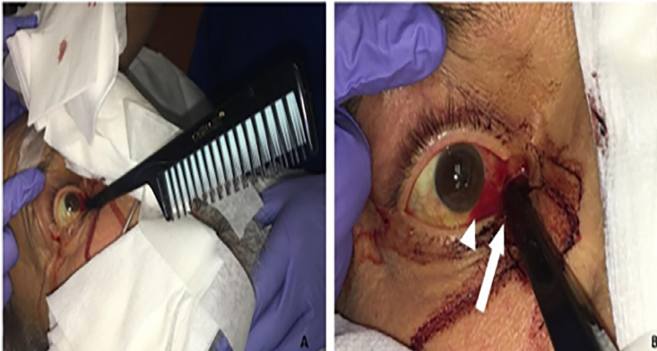
Image 1. Hair comb impaled into the right inferomedial orbit (A) with higher magnification (B) of the foreign body with right conjunctival laceration at the nasal limbus extending inferonasally (arrow) with associated subconjunctival hemorrhage